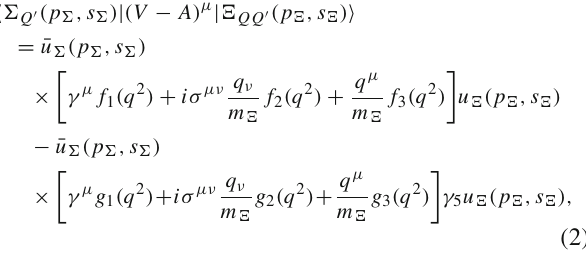
denotes the spin of the heavy quark system. h J h